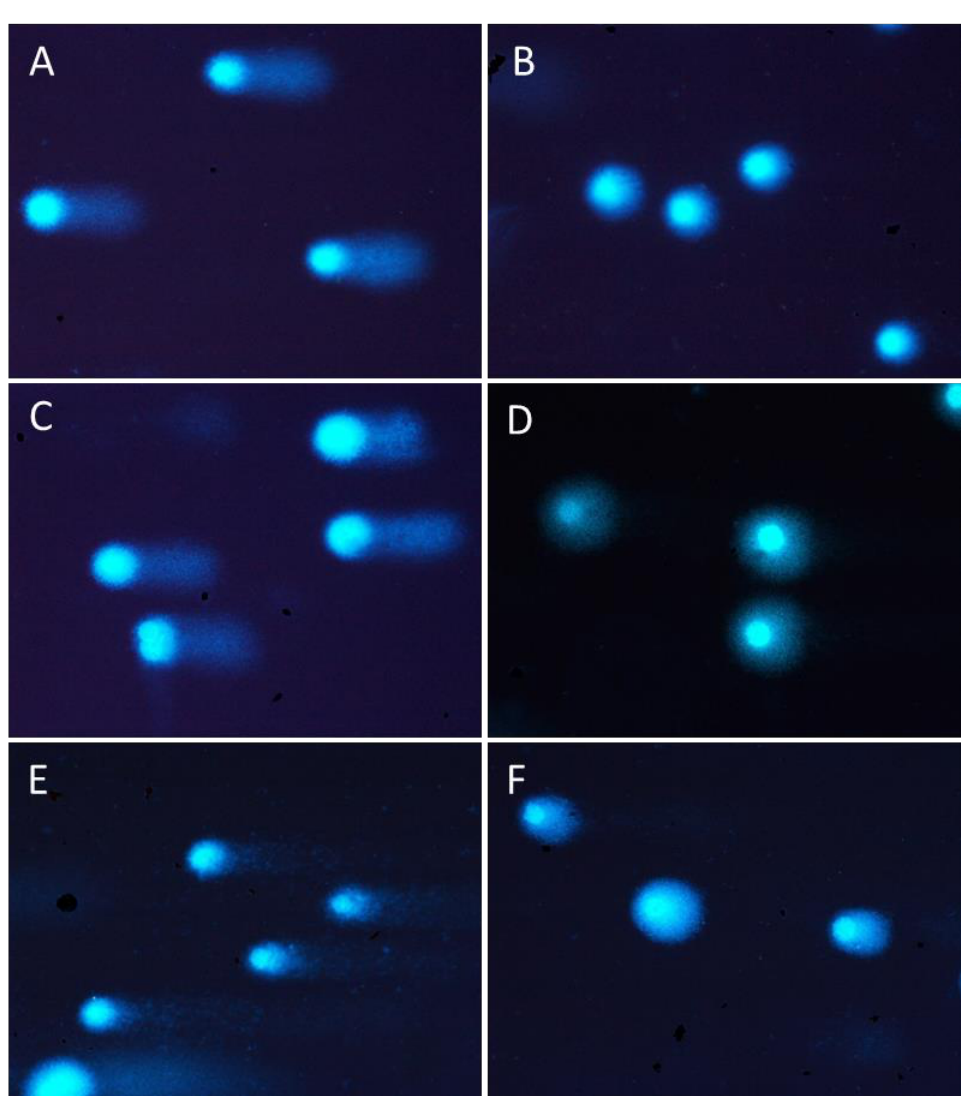
Figure 7. Representative photographs of DNA damage of DAPI ( 4′ ,6-diamidino-2-phenylindole) stained comets in HeLa cells: ( A ) — 50 µM cisplatin, ( B — negative control, ( C ) — 50 µM HHSB; in Caco-2 cells: ( D ) — 10 µM CuHHSB; in LLC-PK1 cells: ( E ) — 50 µM CuHHSB, and ( F ) — 50 µM HHSB. Fluorescence microscopy (Nikon, Tokyo, Japan), objective 20 ×